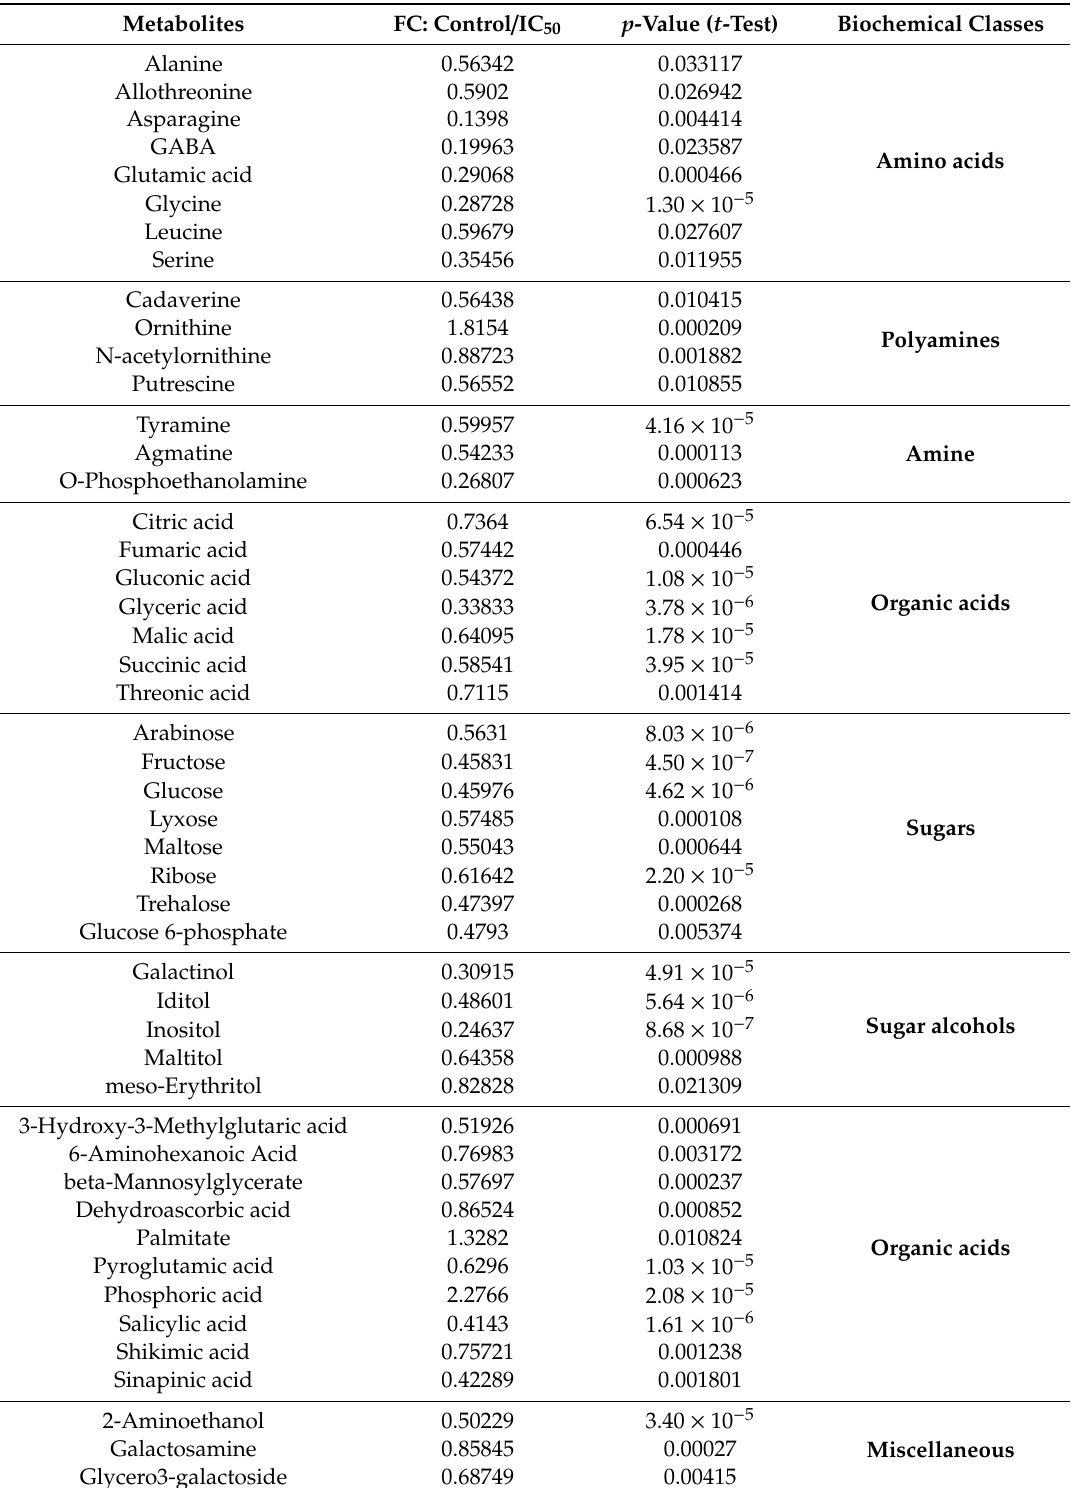
Table 1. The gas chromatography mass spectrometry (GC-MS) based metabolomic data obtained from Arabidopsis roots treated for 14 d with nerolidol concentration of 120 µ M, showing significantly changed metabolites [cut o ff s; fold change (FC) ≥ 1 and a p value ≤ 0.05]. Full data are reported in Table S2 ( n =